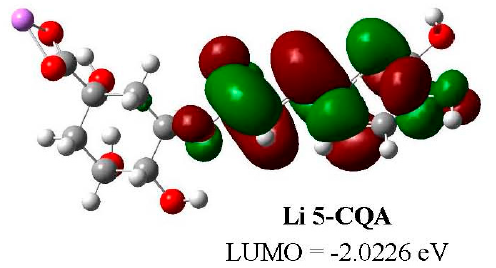
Figure 6. The HOMO (highest occupied molecular orbital) and LUMO (lowest unoccupied molecular orbital) orbitals calculated in gas phase 5-CQA and Li 5-CQA.